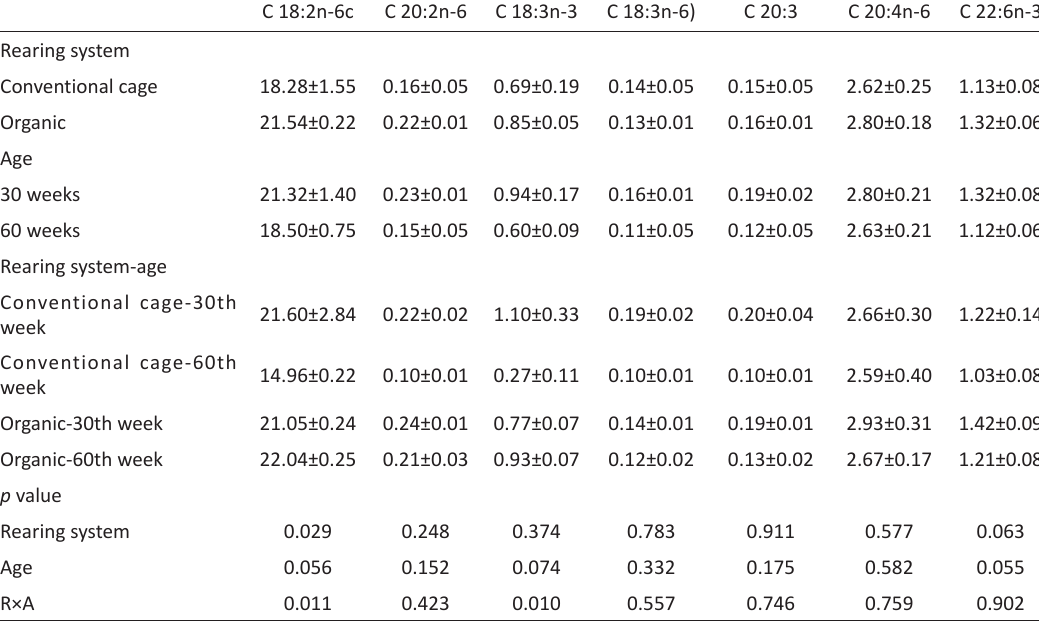
Table 6. Levels of polyunsaturated fatty acids in the egg yolks